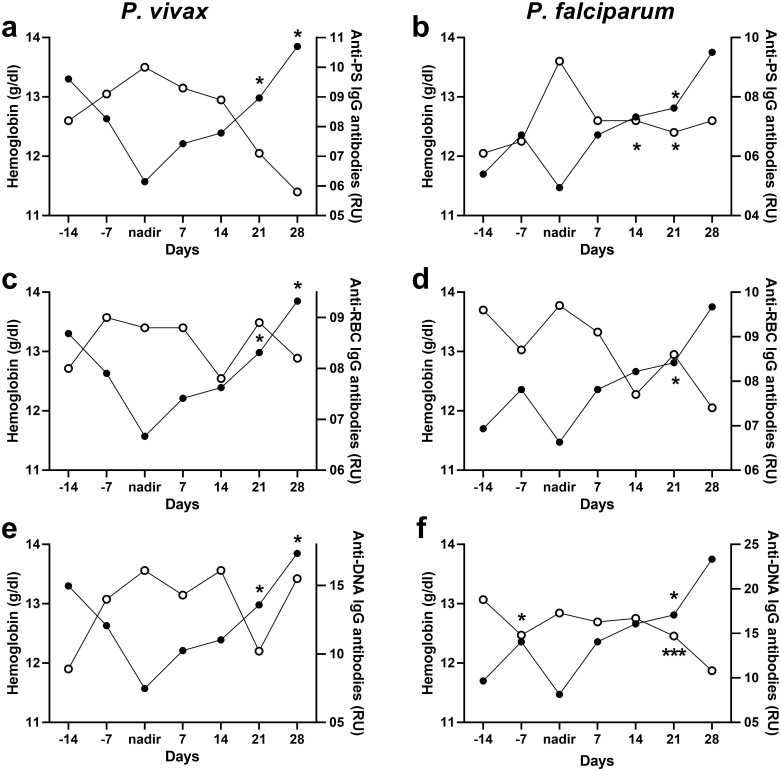
Dynamics of autoantibodies and hemoglobin levels in Colombian P. vivax and P. falciparum patients.Longitudinal analysis of hemoglobin (black circles) and autoantibody (white circles) dynamics of Colombian P. vivax (a,c,e) and P. falciparum patients (b, d, f) normalized to the nadir in each patient. Significant assessed by paired Student T-test for differences for each point with the nadir value are indicated *p≤0.05, ***p≤0.005).